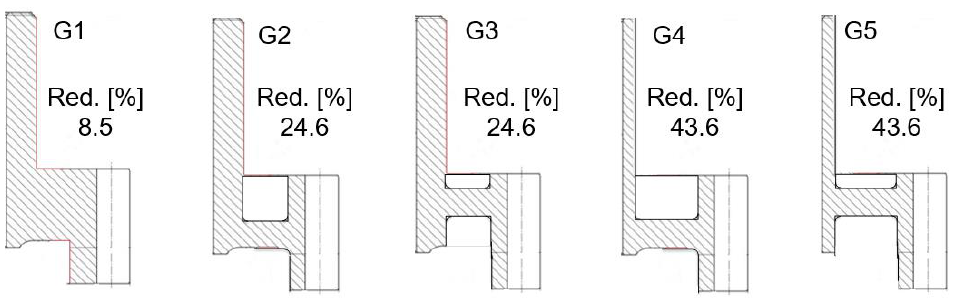
Figure 2. Geometry variations G1–G5 and percentage of mass reduction achieved.